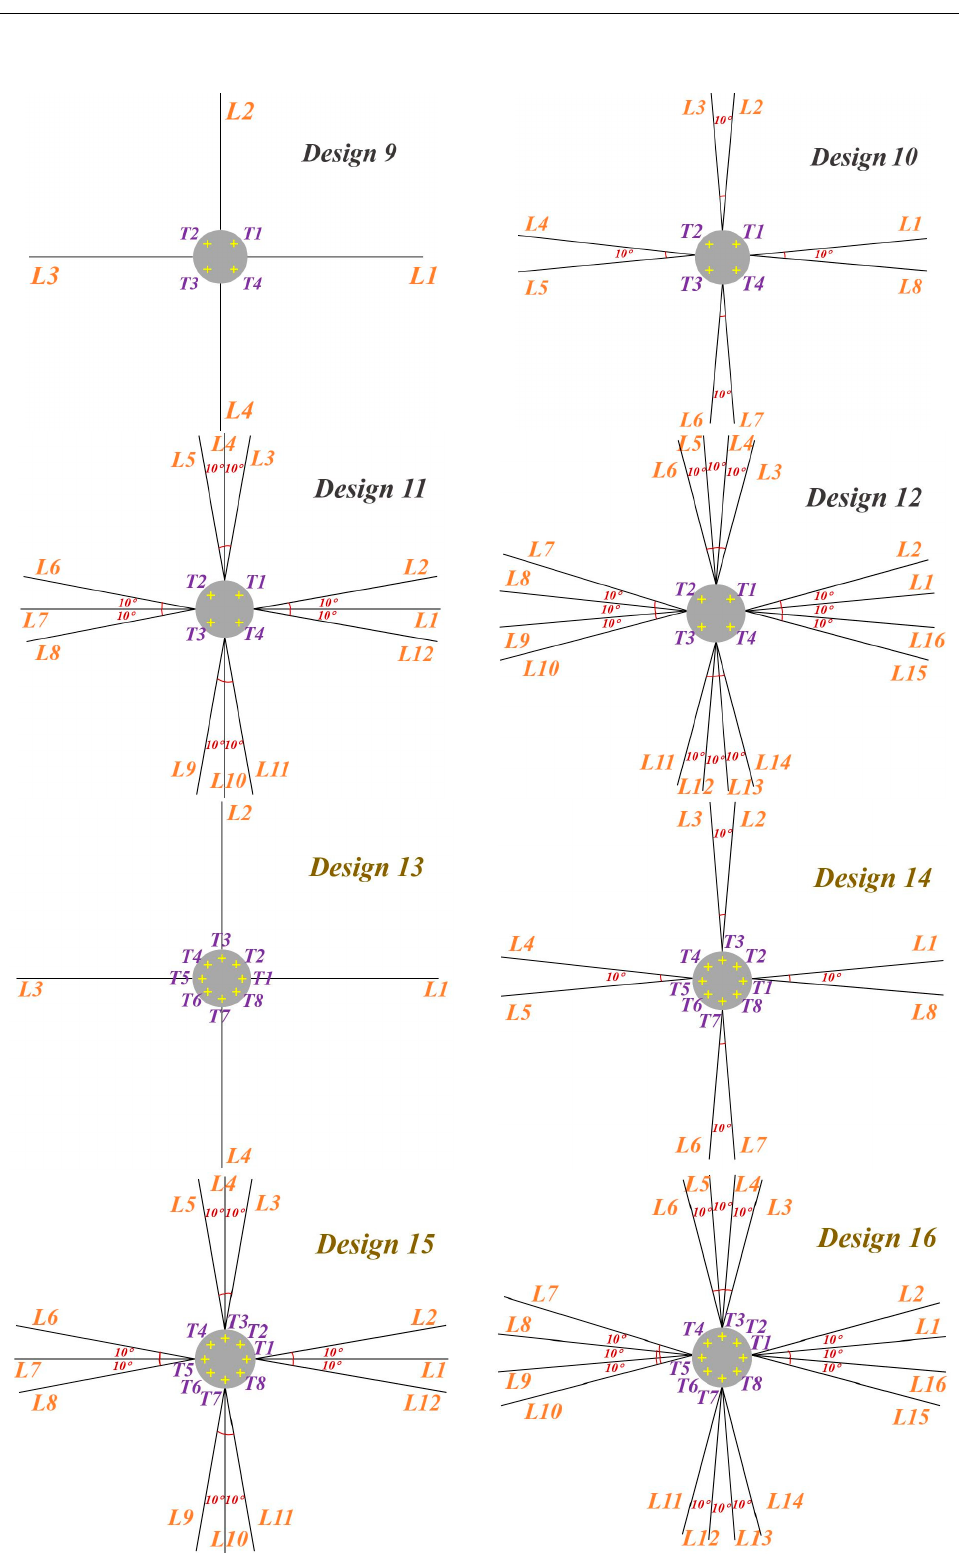
Figure 3. Design of positioning system.